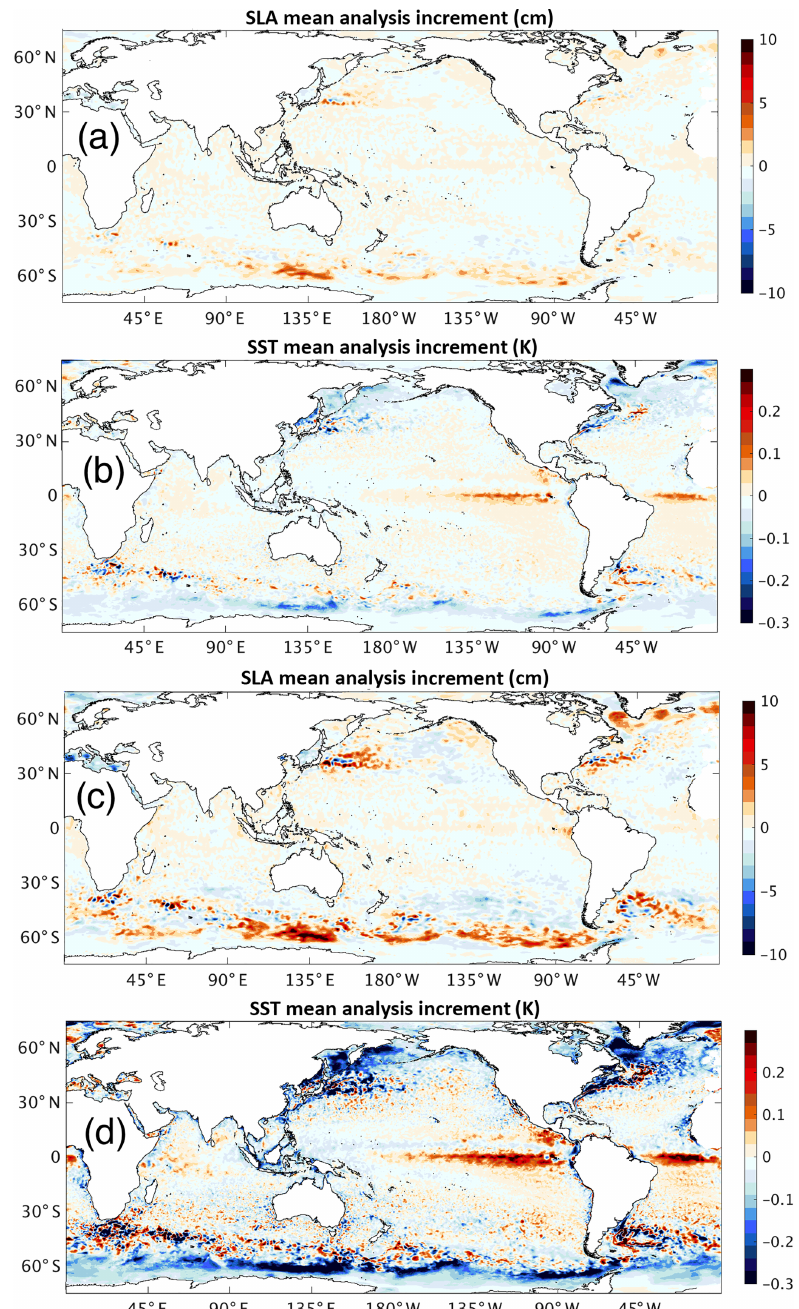
Figure 4. Mean analysis increments for sea-level anomaly (SLA) and sea surface temperature (SST) for the 1-day (a, b) and 3-day system (c, d)